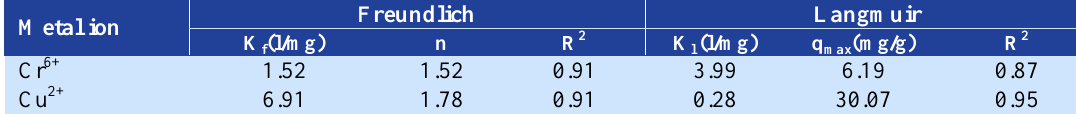
Figure 10. Comparison of the effect of time and initial concentration on adsorption of chromium on MCh/Fe-Zr nanoparticles in temperature of 25 o C, adsorption dose of 2 g/l, speed 300 of rmp, time of 60 minutes, and pH of 9 Table 1. Resulting parameters from adsorption isotherm